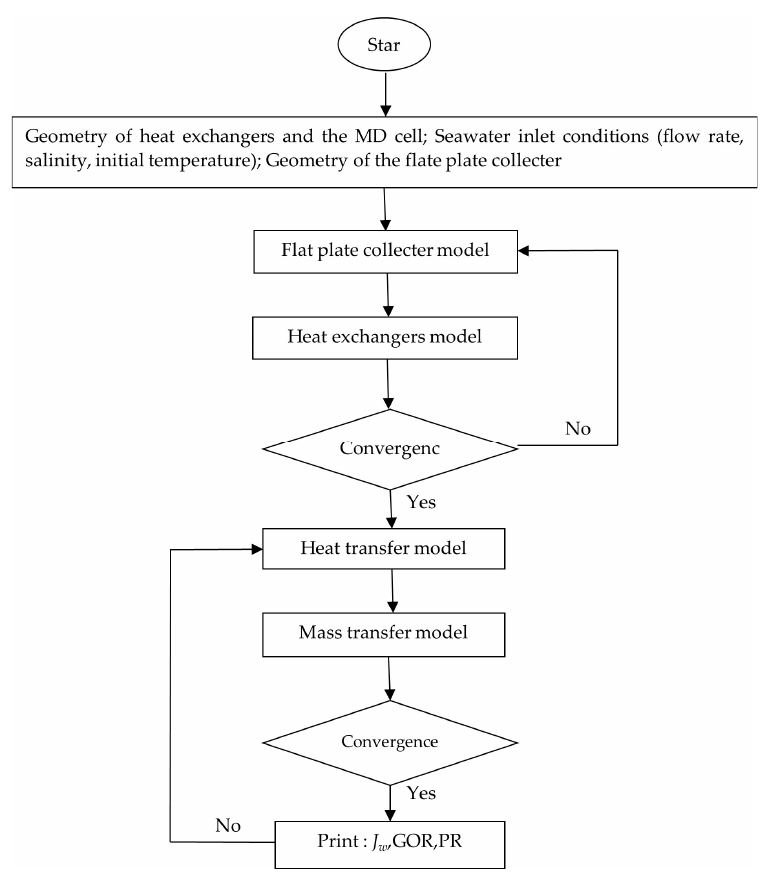
Figure 3. Flowchart of the optimal design.